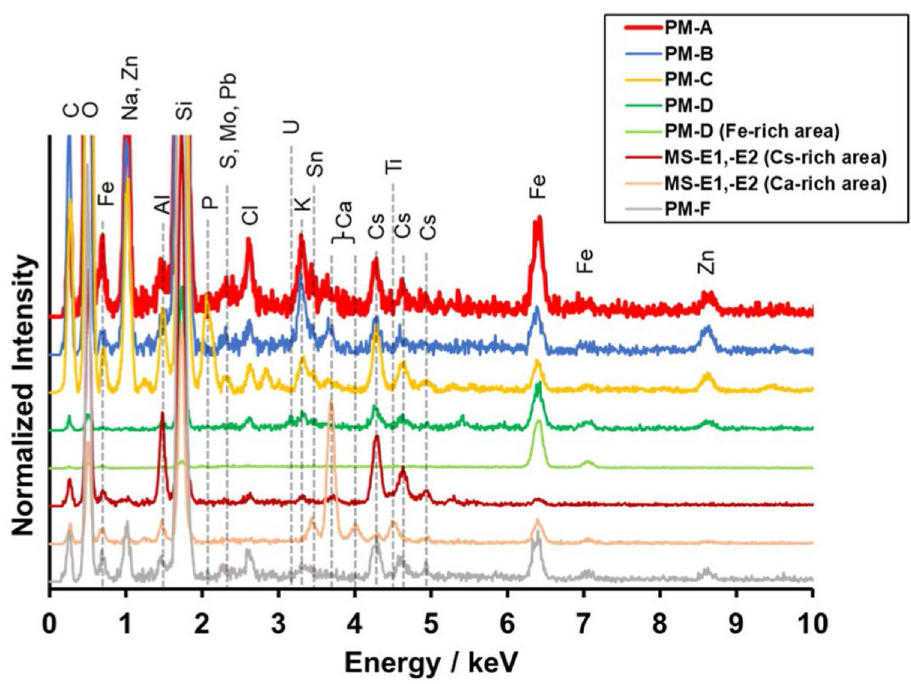
Figure 3. EDS spectra of the seven RPs. The carbon was from the carbon coating done during sample